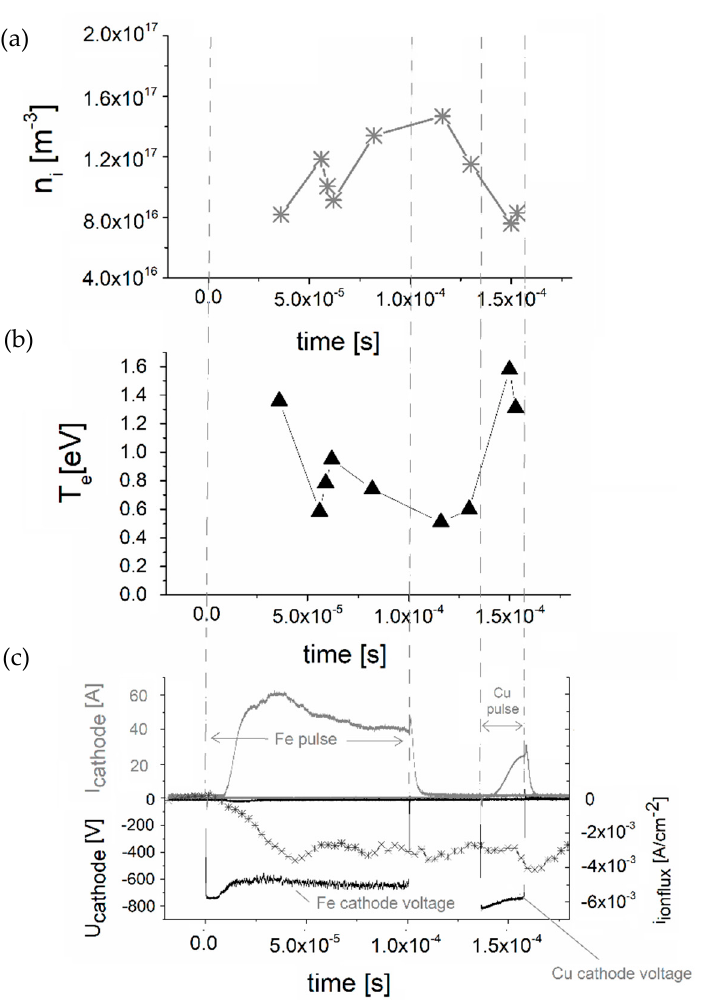
Figure 2. Time evolution of plasma parameters like, ion plasma density n i ( a ), tail electron temperature T e ( b ) and ion flux density on the probe i ionflux ( c ) of reactive r-HiPIMS without applied ECWR RF power.